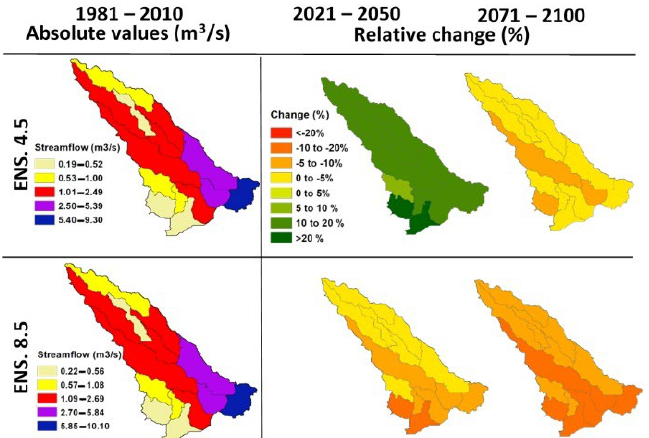
Figure 9. Catchment-scale distribution of growing season average streamflow for the reference period (mm) and the relative change compared to the reference period (%) for each RCP.